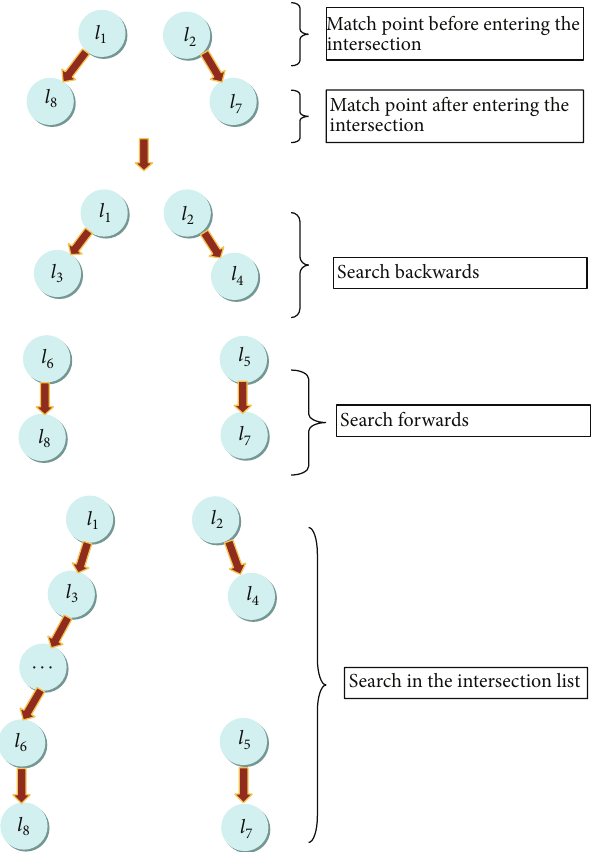
Figure 8: Search process of the initial analysis.